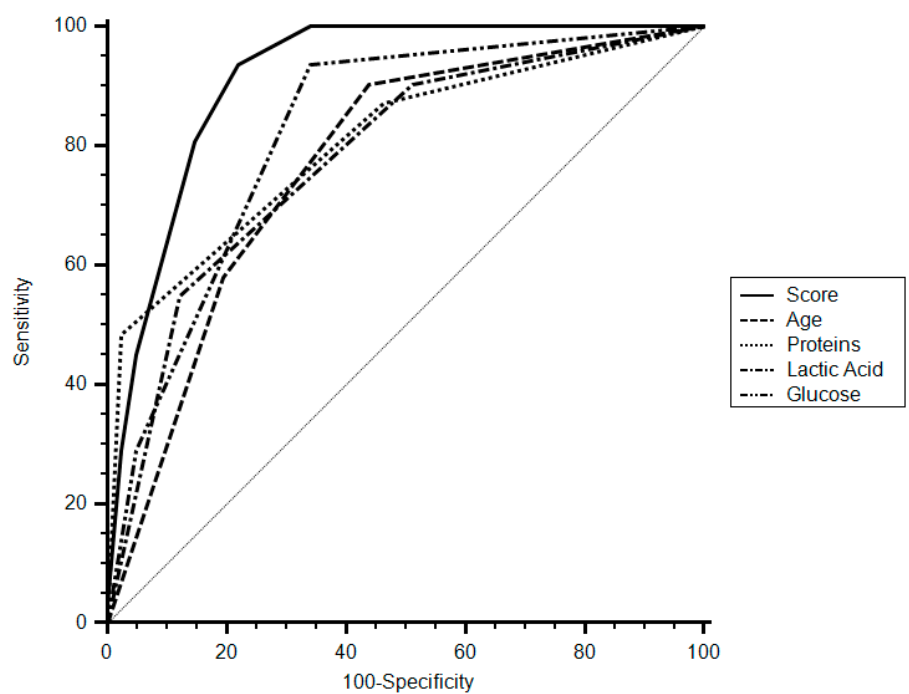
Figure 2. Receiver operating characteristic curve (ROC) for score and categorized variables. AUC, area under the